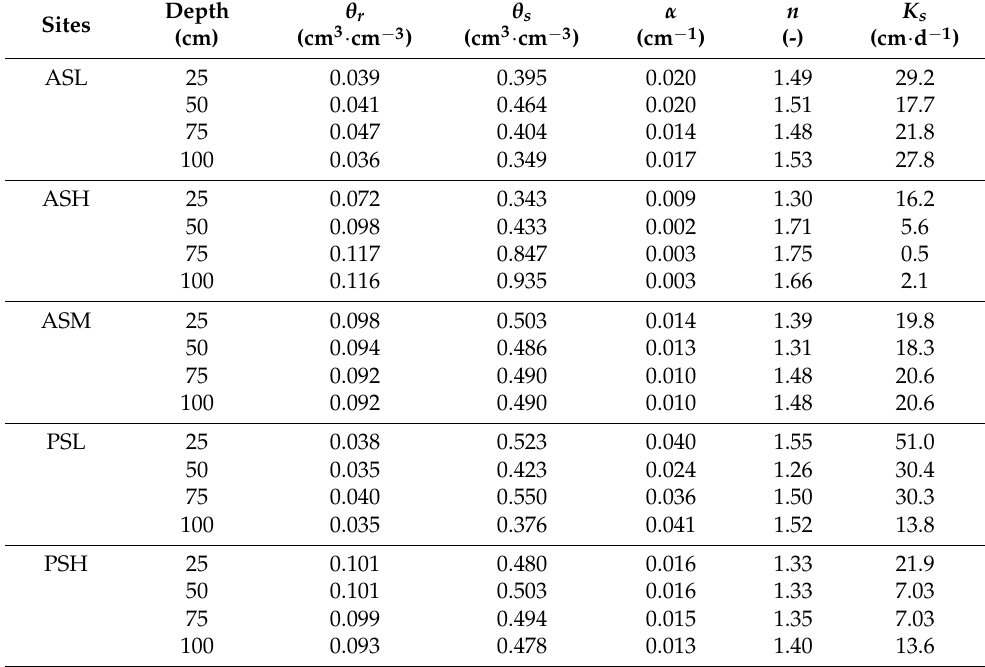
Table 4. The soil hydraulic parameters for four depths of five experimental